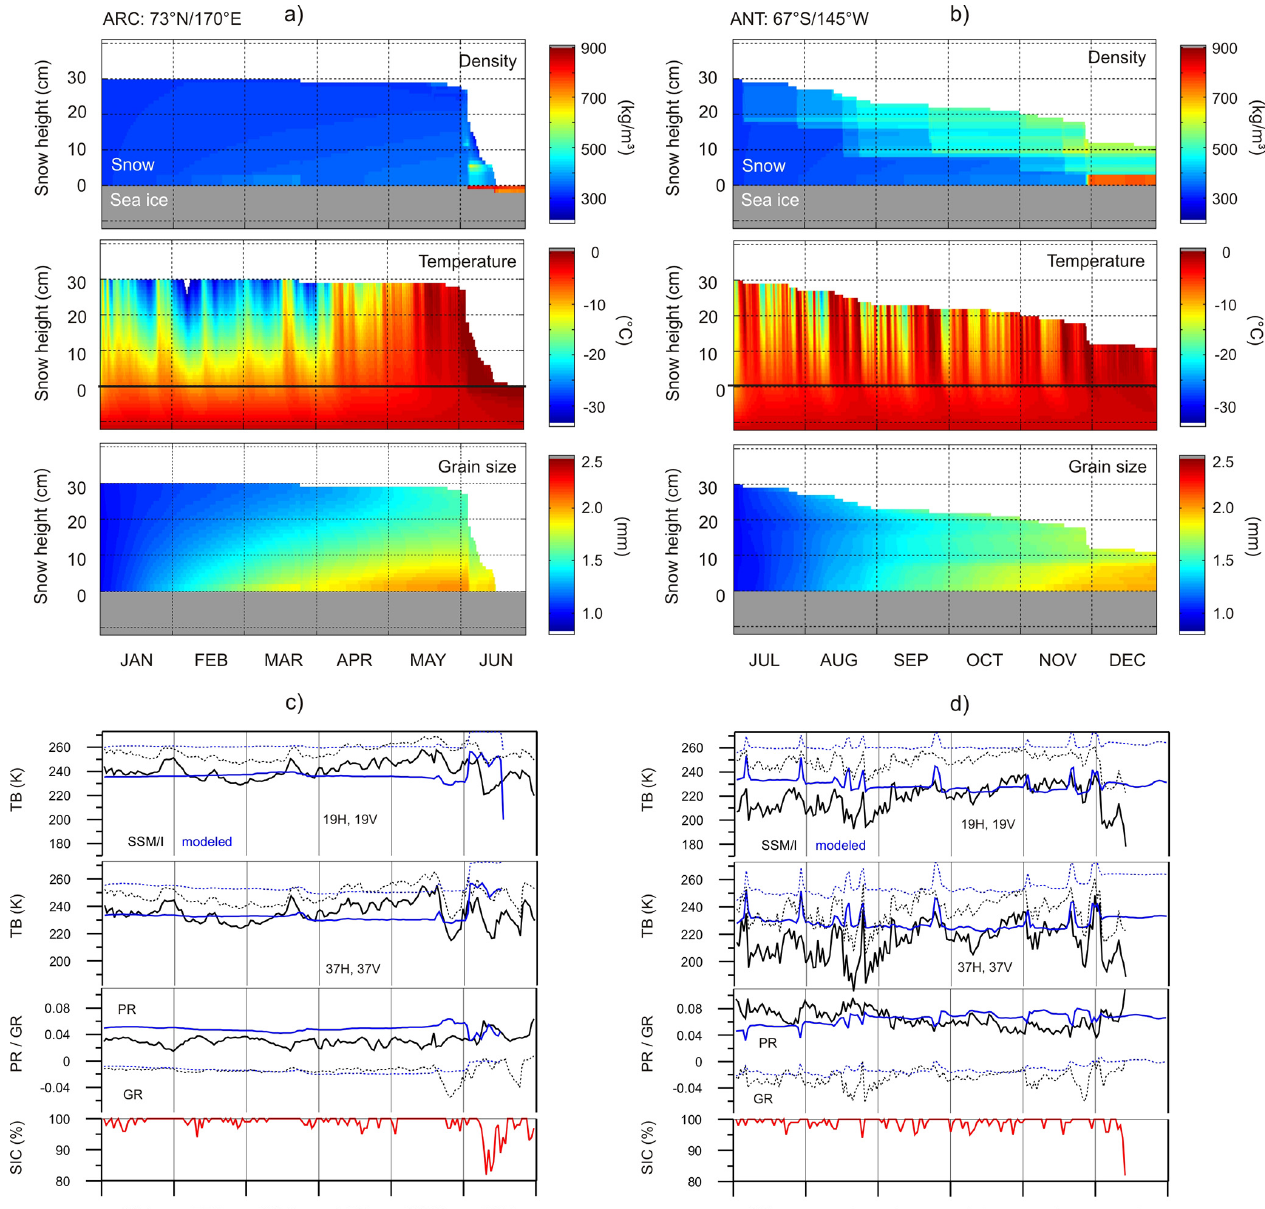
Fig. 3. Snow pack evolution from SNTHTERM: Density, Temperature and Grain size for the Arctic ( a , January–June 2008, 70 ◦ N/170 ◦ W) and Antarctic ( b , July–December 2008, 70 ◦ S/85 ◦ W). Associated simulated (blue) and observed (black) 19GHz and 37GHz brightness temperatures (bold: horizontal pol.; dotted: vertical pol.), Polarization Ratio (PR) and Gradient Ratio (GR) as well as Nasa Team sea-ice concentrations (red) for the same positions in the Arctic (c) and Antarctic (d)